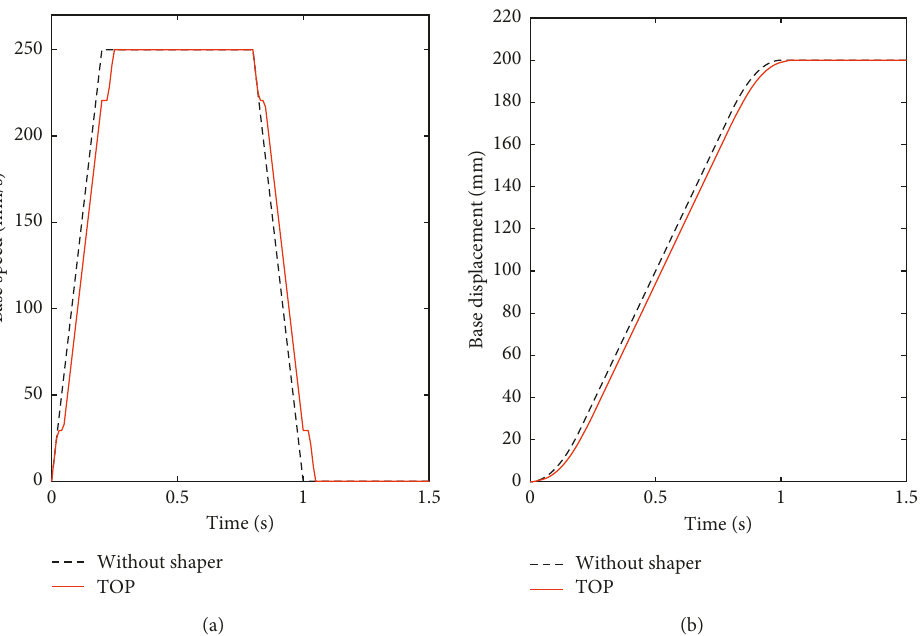
Figure 4: Positioning base velocity and displacement curves before and after the effect of the two-mode vibration cascade shaper: (a) velocity curve; (b) displacement